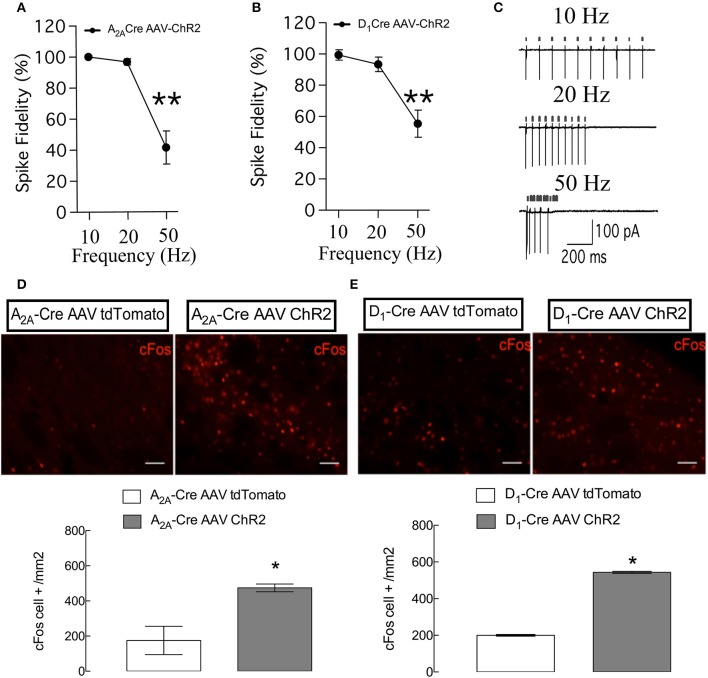
Specific control of the synchronicity between the delivery of light pulses and the presence of action potentials and c-fos immunostaining in the two populations of neurons of the DLS. (A) High spike fidelity when the frequency of 10 and 20 Hz but not 50 Hz of light is delivered in DLS slices from A2A-Cre (A) and D1-Cre (B). (C) Representative recordings of 10, 20, and 50 Hz, small arrows on top of the action potentials indicate the delivery of the light pulses. Representative immunohistochemistry for c-fos in DLS slices from mice submitted to the behavioral tests (D,E top). Both populations of ChR2-expressing (iMSNs in D and dMSNs in E bottom) increased the expression of the c-fos gene. For spike fidelity the data are mean ± SEM of n = 7–8 per group. **p < 0.05 when compared to the theoretical value of 100%. For c-fos the data are mean ± SEM of n = 4–5 for the A2A-Cre and 5–7 for the D1-Cre mice. *p < 0.05 when compared to the respective AAV-tdTomato control. Scale bars are 50 μm.